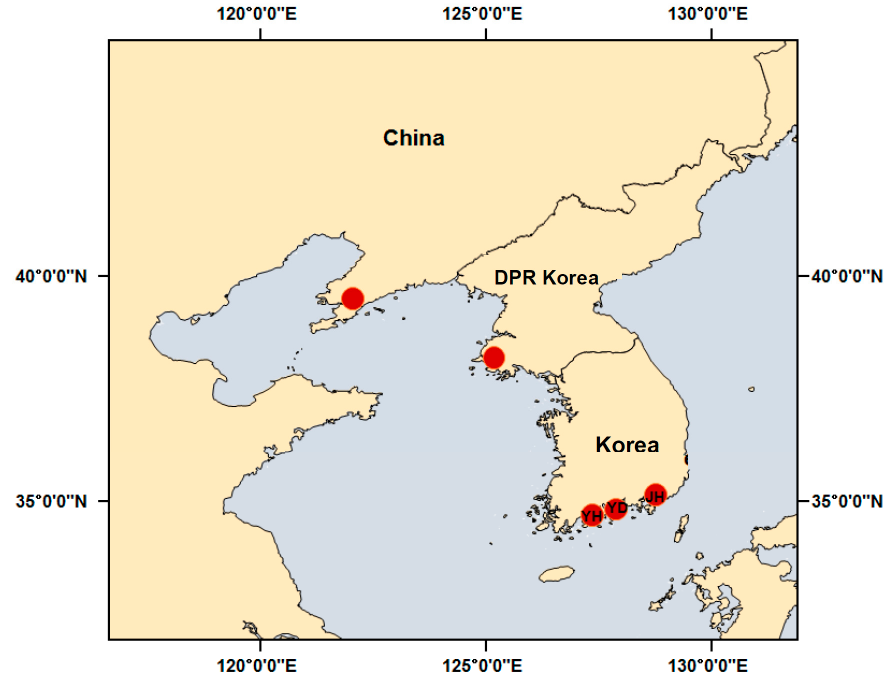
Figure 1. Geographic locations of sampling sites. China, Democratic People’s Republic of Korea (DPR Korea) and Korea.